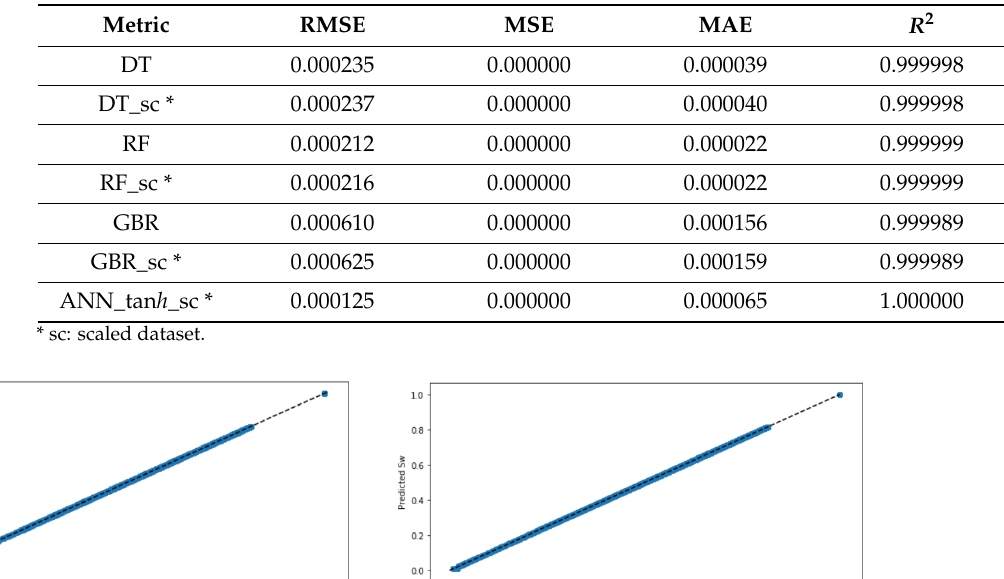
Table 5. Models performance evaluation of two phases dataset for S w .